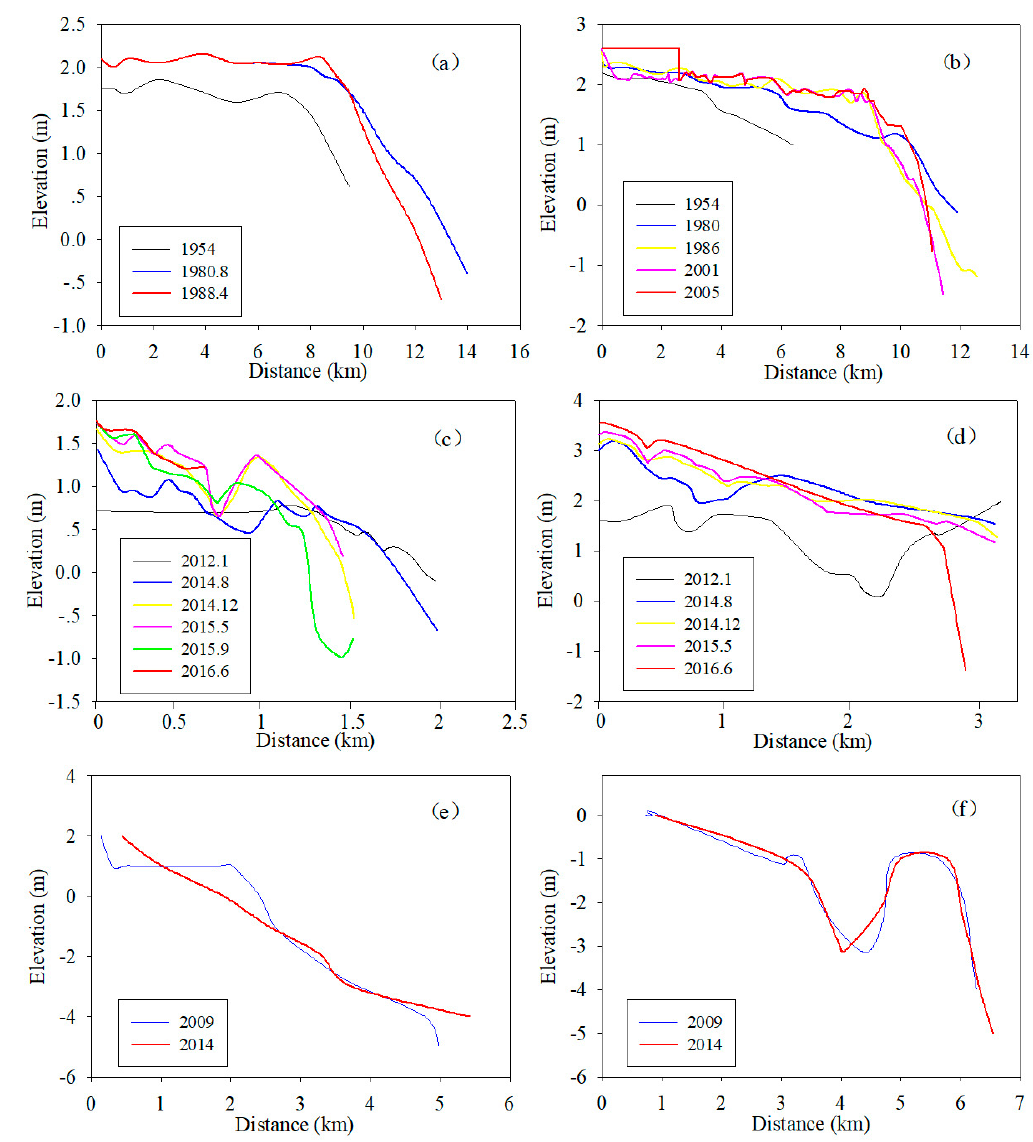
Figure 9. Change in the tidal flat profiles of the study area: ( a ) revised from Fang et al., 1992; ( b ) revised from Wang et al., 2003; ( c , d ) measurements in this study; ( e , f ) revised from Gu, 2018).